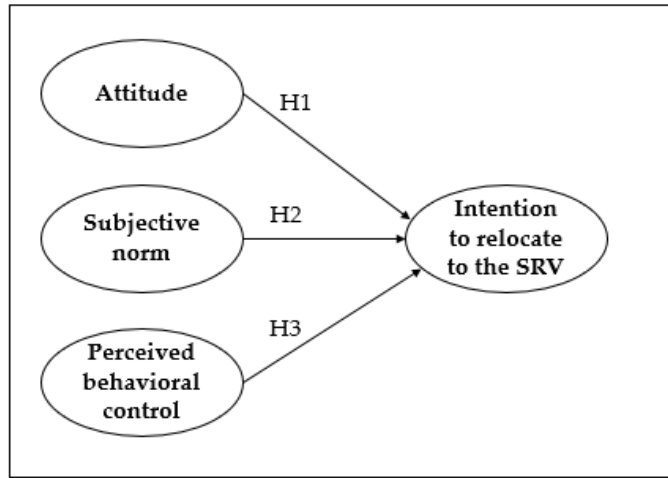
Figure 1. A proposed research framework.